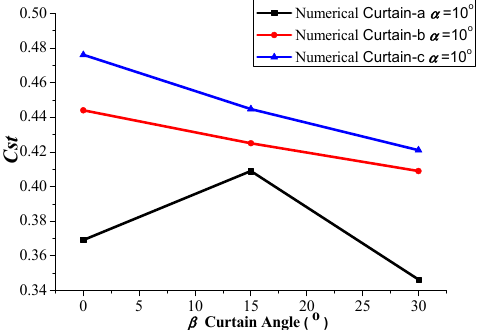
Figure 11. Static torque coefficients for different curtains ( θ = 45°).